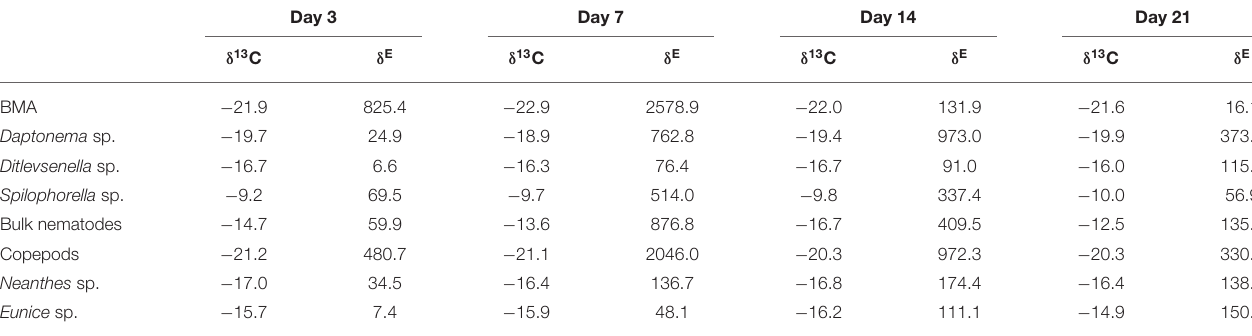
TABLE 2 | 15 N enrichment and natural abundance δ 13 C in primary producers and infauna over the 21-day isotope tracer